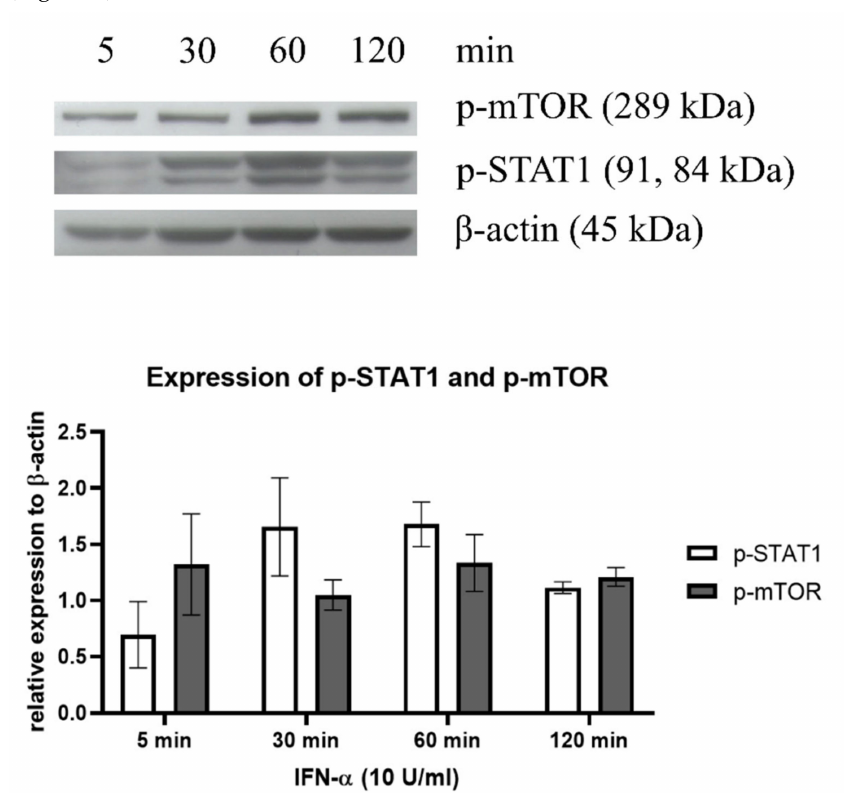
Figure 4. Western blot analysis of an autophagy inducer (p-mTOR) and the signaling activator (p- STAT1) protein expression in representative cells that rendered IFNR after treatment with IFN- α . LLC- MK2 cells were treated with IFN- α (10 U/mL) for 5, 30, 60, and 120 min. The cellular total proteins were extracted and transferred to nitrocellulose membranes. The membranes were immunostained with p-mTOR and p-STAT1 antibodies and processed for reaction color development. β -Actin was used as an internal control. The experiment was performed in triplicate and the band density was normalized with β -actin. Protein electrophoresis films were digitized and the relative density level of p-mTOR and p-STAT1 were measured by ImageJ ®